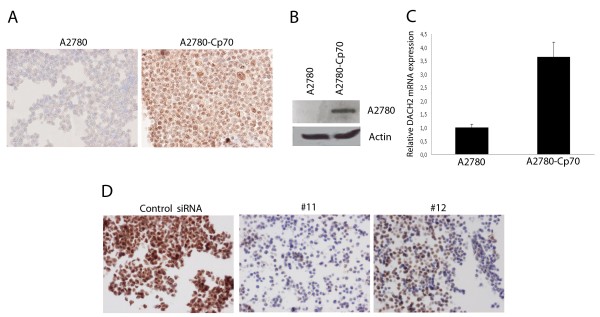
Expression of DACH2 in the cisplatin-sensitive A2780 ovarian cancer cell line compared to the cisplatin-resistant cell line A2780-Cp70 and validation of the specificity of the DACH2 antibody in A2780 ovarian cancer cells. Substantially higher DACH2 protein expression was seen in the cisplatin-resistant A2780-Cp70 cell line compared to its parental cisplatin-sensitive A2780 cell line by A) immunocytochemical staining and (B) immunoblotting, showing a major band at 62 kDa corresponding to the expected molecular weight of the DACH2 protein. (C) Relative mRNA expression was also higher in the A2780-Cp70 cells compared to A2780 cells as shown by qRT-PCR analysis. Data shown are mean ± SD of a representative experiment of two independent experiments performed in triplicate. (D) DACH2 protein expression was significantly decreased after transfection with siRNA against DACH2 in A2780-Cp70 cells as shown by immunocytochemistry 72 hrs post-transfection.